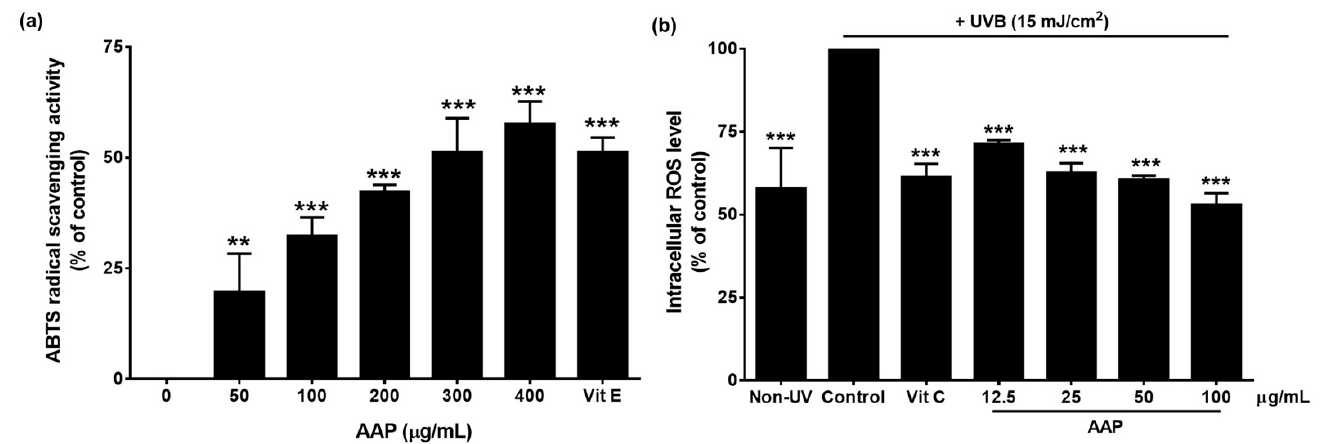
Figure 2. Antioxidant activities of AAP. The antioxidant activities of AAP were determined by ABTS assay ( a ) and DCF-DA Figure 2 . Antioxidant activities of AAP . The antioxidant activities of AAP were determined by ABTS assay ( a ) and DCF - fluorescent assay ( b ). For ABTS assay, the AAP (0–400 µ g/mL), and Vit E at 15 µ g/mL was used as a positive control. The DA fluorescent assay ( b ). For ABTS assay, the AAP ( 0 – 400 µg / mL ) , and Vit E at 15 µg / mL was used as a positive control . intracellular ROS production was calculated as the percent of inhibition. For DCF-DA antioxidant activity, primary human The intracellular ROS production was calculated as the percent of inhibition . For DCF - DA antioxidant activity, primary skin fibroblasts were exposed to UVB at 15 mJ/cm 2 using ultraviolet crosslinker. The intracellular ROS after UVB irradiation human skin fibroblasts were exposed to UVB at 15 mJ / cm 2 using ultraviolet crosslinker . The intracellular ROS after UVB irradiation in fibroblasts was determined by DCF - DA dye . Vit C at 25 µg / mL was used as positive control . Data are rep- in fibroblasts was determined by DCF-DA dye. Vit C at 25 µ g/mL was used as positive control. Data are represented as resented as mean ± S . D . values of three independent experiments, ** p < 0 . 01 and *** p < 0 . 001 vs . the control . mean ± S.D. values of three independent experiments, ** p < 0.01 and *** p < 0.001 vs. the